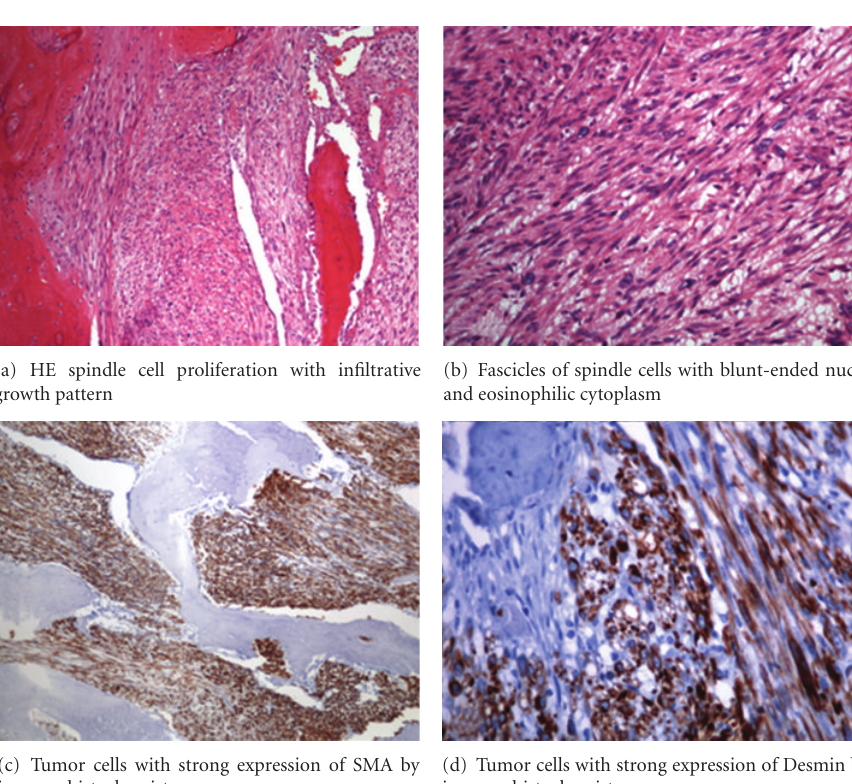
Figure 3: Histologic workup of the tumor tissue: (a) HE, (b) HE, (c) SMA, (d)